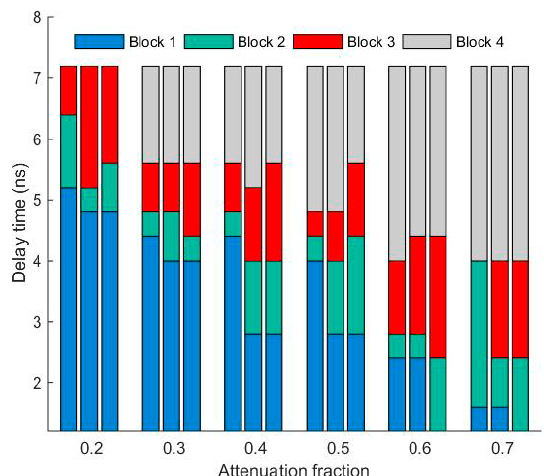
Figure 15. The statistical chart of all data with different d t , k and A . Block 1 represents the area of no solution, Block 2 represents the area of terrible solution, Block 3 represents the area of usable solution at the rise edge, Block 4 represents the area of solution at the trailing edge. In one group of experiments, the returned pulse amplitudes were assigned to be 0.4 V, 0.8 V and 1.2 V, and the left one of each three bars is the minimum pulse amplitude (0.4 V). The choice criterion of circuit parameters should follow the range performance (red area) of the minimum pulse amplitude.